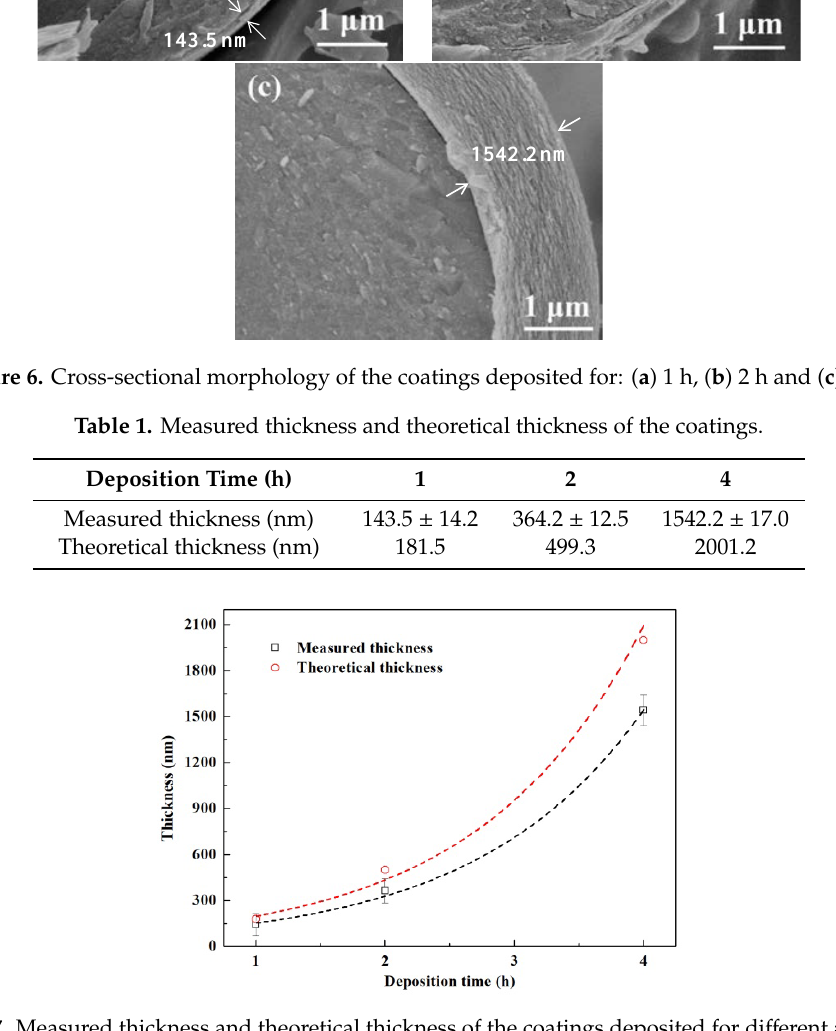
Figure 7. Measured thickness and theoretical thickness of the coatings deposited for different amounts of time.